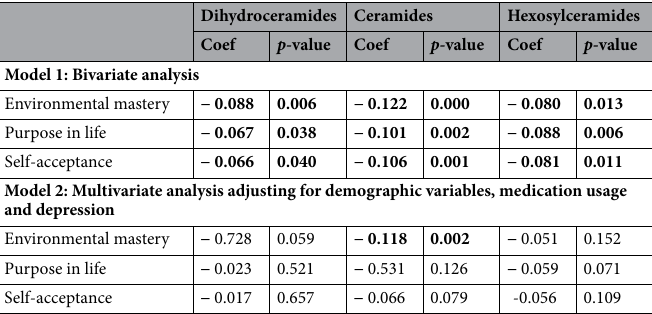
Table 2. Association between blood levels of sphingolipid classes and well-being dimension scores. p -values < 0.05 and their standardized regression coefficients are denoted in bold.